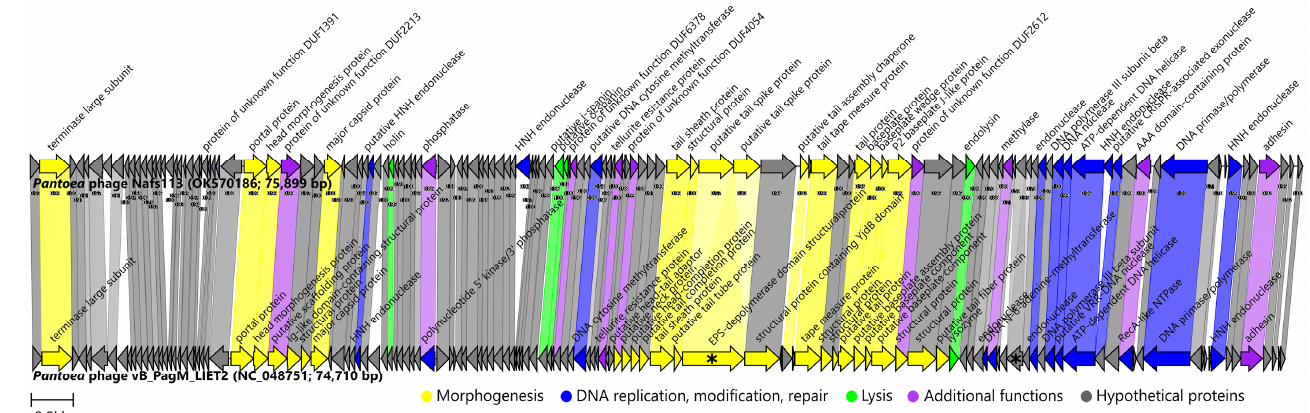
Figure 8. Genome organization and proteome content comparison of Pantoea phage Nafs113 to its closest relative— Pantoea phage vB_PagM_LIET2. Genomes are drawn to scale; the scale bar indicates 2500 base pairs. Arrows representing open reading frames point in the direction of the transcription and are color-coded based on the function of their putative product according to the legend. Slanted labels above the arrows indicate the predicted function for the given ORF putative product in the case it had a function assigned (original annotations from downloaded GenBank files were retained). Ribbons connect phage proteins sharing >30% amino acid sequence similarity and are colored in lighter shades according to the predicted functional group of the respective Pantoea phage Nafs113 ORF product. Ribbon labels indicate the similarity between the connected ORF products and ribbons have their fill color opacity set to the percentage similarity between the respective proteins. Asterisks within two of the arrows representing vB_PagM_LIET2 ORFs indicate that their homologs in Nafs113 are encoded by two distinct ORFs in each